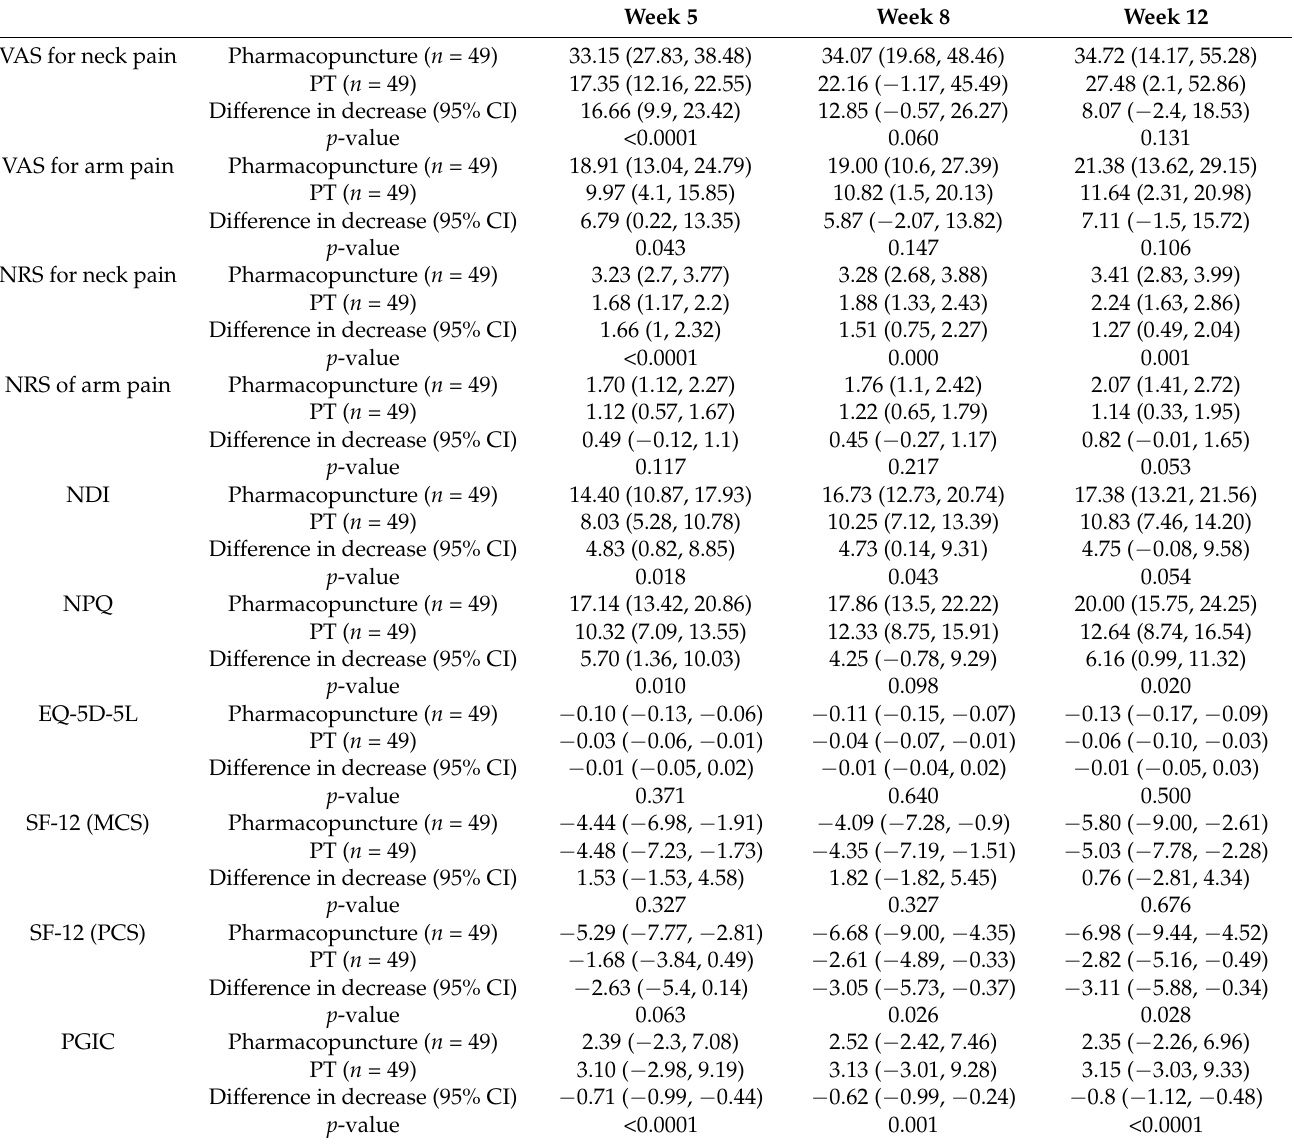
Table 2. Primary and secondary outcomes after treatment at each time